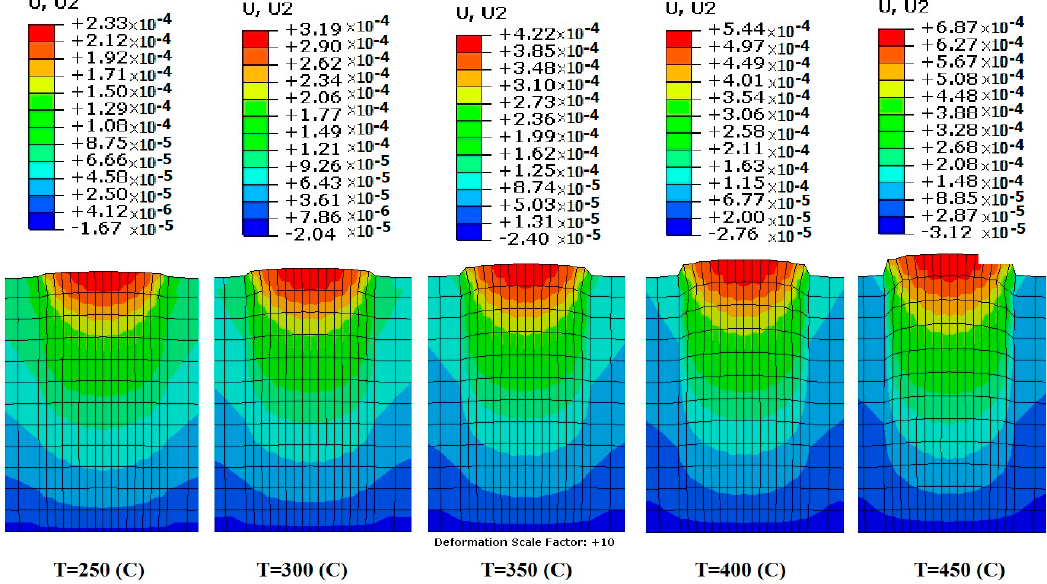
Figure 7. Vertical deformation of the cylindrical TSV shape (in mm).